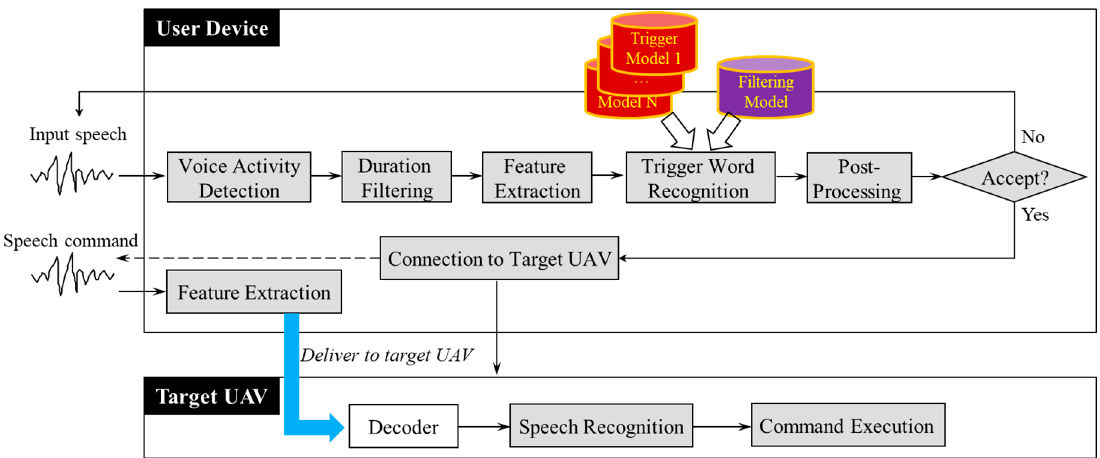
Figure 7. Procedures of proposed multi-channel voice trigger-based front-end and speech